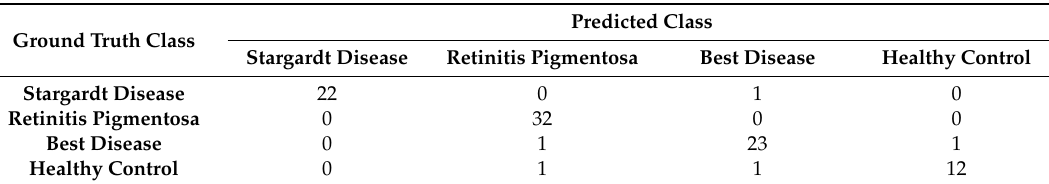
Table 2. Confusion matrix of the deep learning classifier test dataset on a total of 94 fundus autofluorescence (FAF) images of inherited retinal disease (23 Stargardt disease, 32 retinitis pigmentosa, and 25 Best disease images) and healthy controls (14 images).